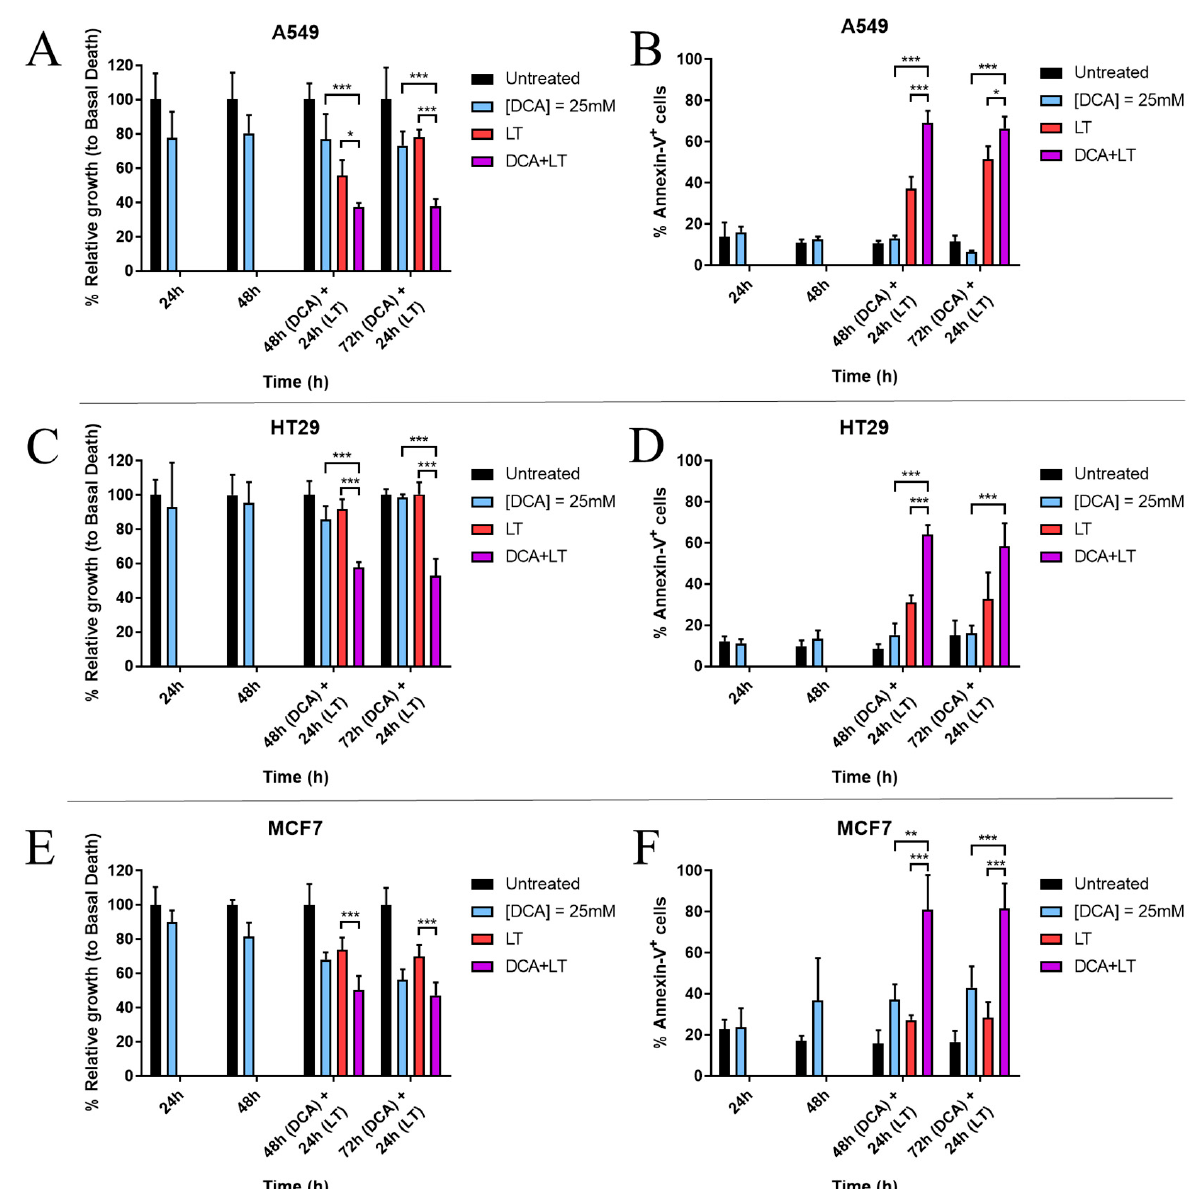
Figure 1. Effect of DCA + LUV-TRAIL (LT) combination in cell growth (MTT assay) and cell death (annexin-V staining and detection by flow cytometry) in ( A , B ) A549, ( C , D ) HT29, and ( E , F ) MCF7 cells. Tumor cells were incubated with DCA (25 mM) for several time points. After either 48 h or 72 h, LT (1000 ng/mL) was added to cells for another 24 h. Results are represented as mean +/ − SD of at least two different experiments with triplicate determinations for each cell line. * p < 0.05; ** p < 0.01; *** p < 0.001. DCA: dichloroacetate.